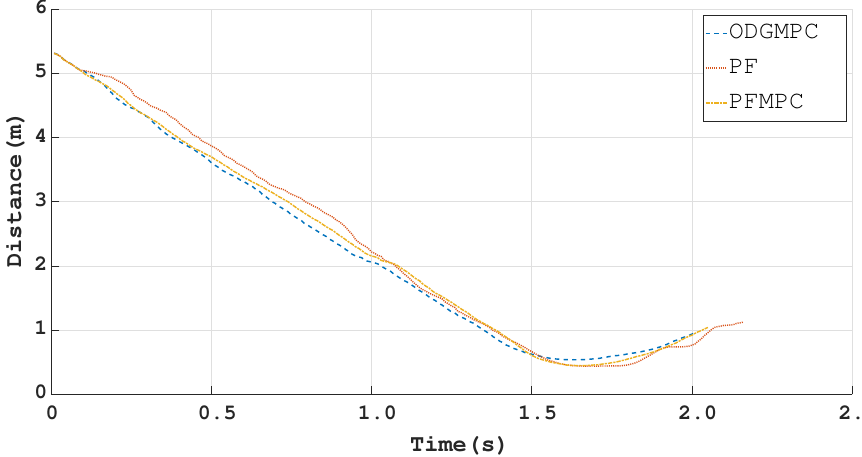
Figure 31. Results of the obstacle distance from Scenario 3 for a dynamic obstacle.